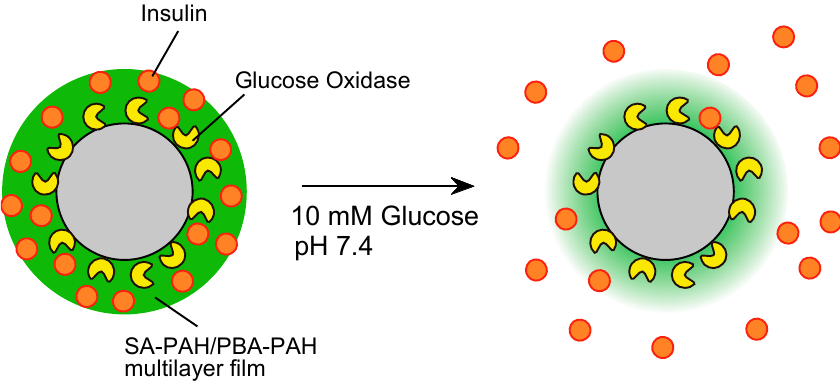
Figure 1. Sequential equilibrium and oxidation reactions of phenyl boronic acid with a diol and H 2 O 2 , respectively.